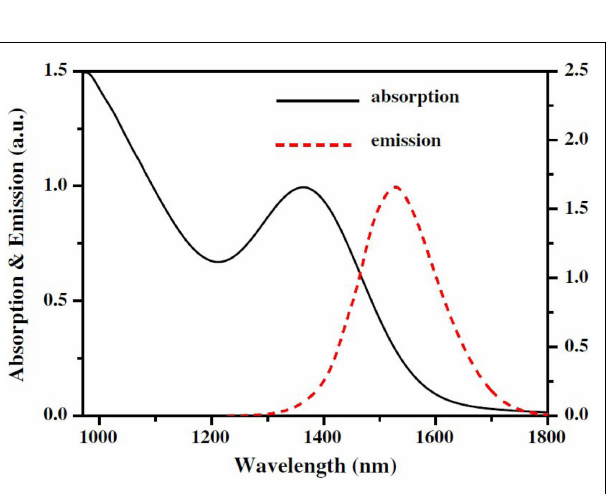
FIGURE 25 |The absorption and PL spectra of QDs, which illustrated a Stokes shift (Guo et al., 2012)